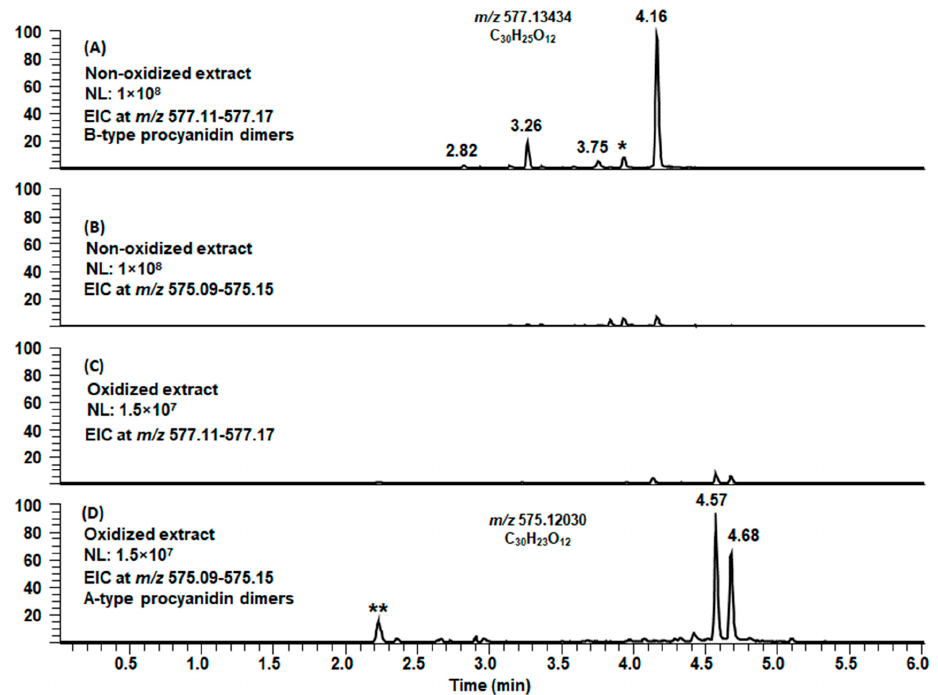
Figure 8. Extracted ion chromatograms (EICs) of the non-oxidized leaflet extract of Microgramma mauritiana ( A ) the ions at m / z 577.11–577.17 showing the presence of B-type procyanidin dimers, ( B ) the ions at m / z 575.09–575.15 and of the oxidized extract of Microgramma mauritiana ( C ) the ions at m / z 577.11–577.17 and ( D ) the ions at m / z 575.09–575.15 showing the presence of A-type procyanidin dimers. (*) the ion corresponds to the isotopic signal of a doubly charged molecular ion for a tetrameric procyanidin. (**) the ion has the same elemental composition as A-type PC dimers but different fragment ions, NL = normalized intensity. Note that this study was qualitative, and the intensities cannot be compared as such.